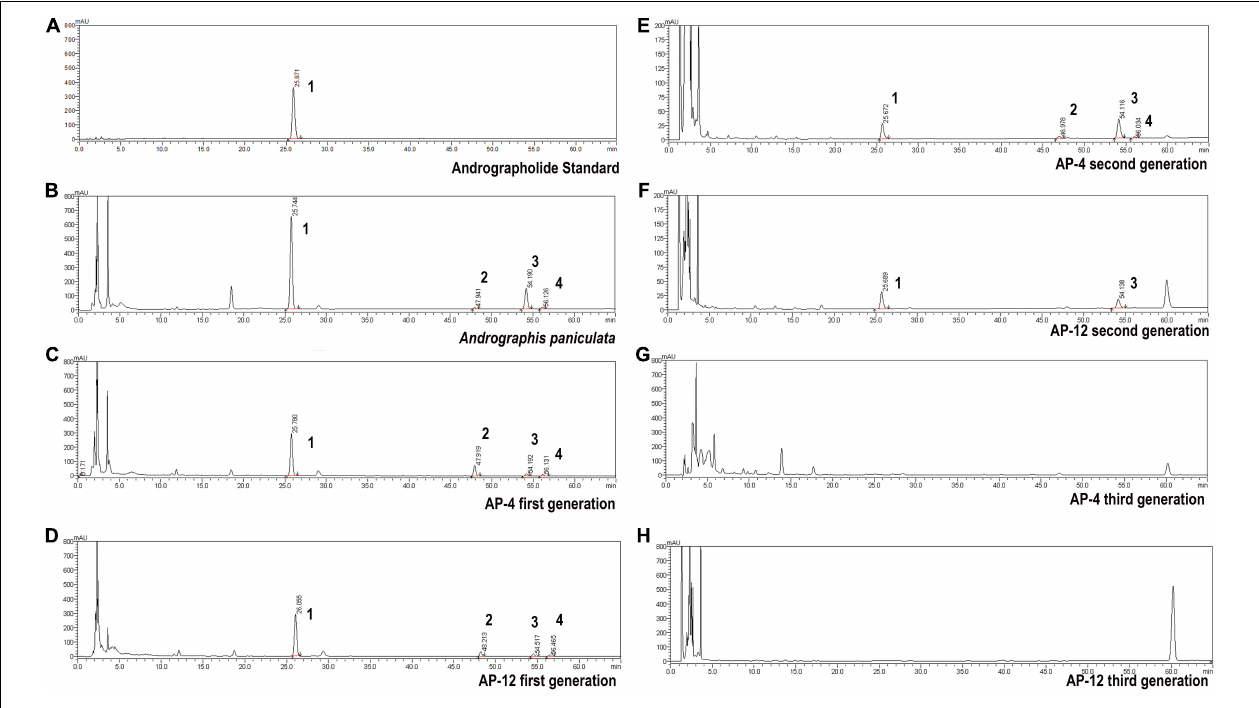
FIGURE 8 | High-performance liquid chromatograms of AD (1), NAD (2), DAD (3), and DDAD (4). (A) Andrographolide standard. (B) Andrographis paniculata. (C) AP-4 first generation. (D) AP-12 first generation. (E) AP-4 second generation. (F) AP-12 second generation. (G) AP-4 third generation. (H) AP-12 third generation.